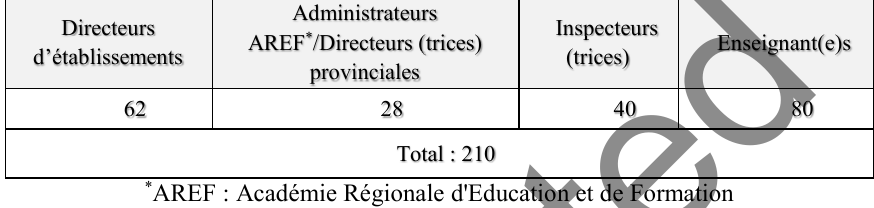
Tableau 2 : les AREF ressources, lors de l’étape exploratoire de la recherche . Oriental Fès – Meknès Rabat – Salé -